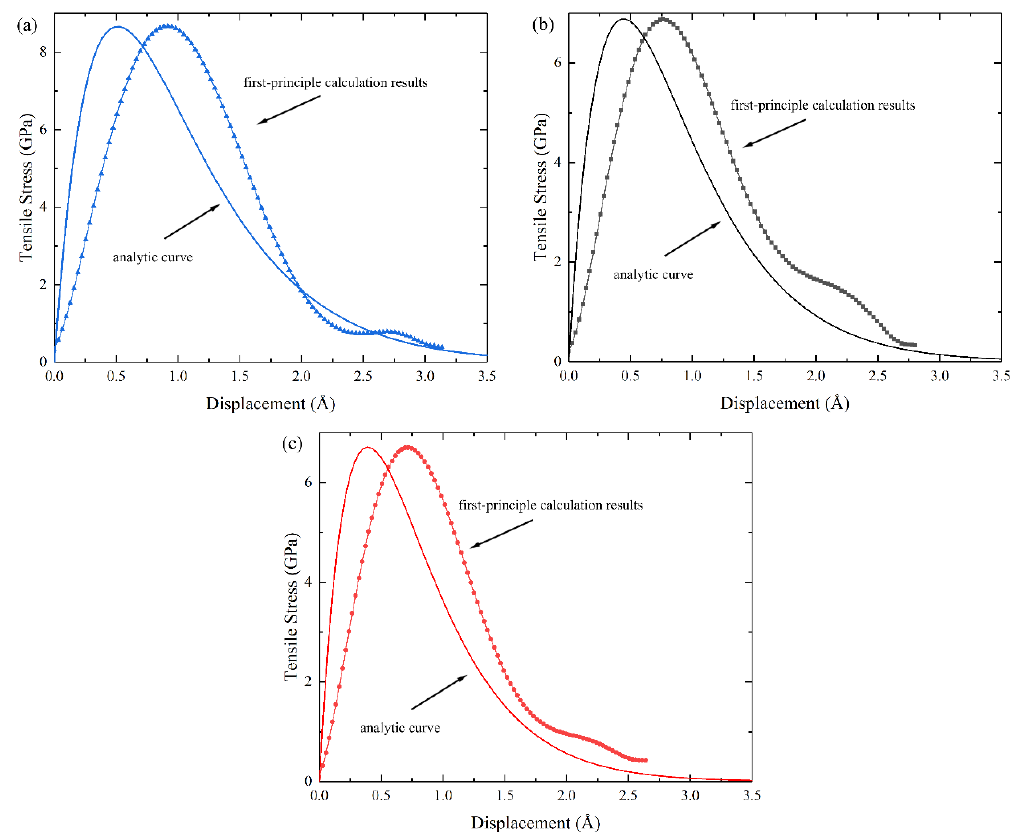
Figure 5. The potential energy-displacement curve of the three terminated c-ZrO 2 (001)/α - Al 2 O 3 (11 02) interfaces. The analytical curves based on Equation (2) and the curves from first-princi- ple calculations are shown as well. ̄